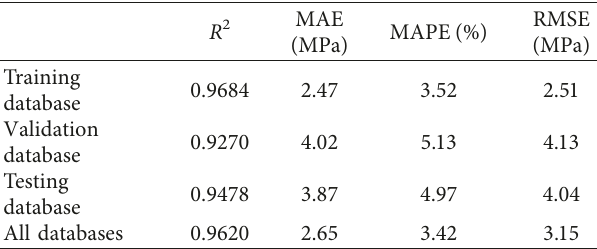
Figure 7: Fitting curve of outputs and targets. Table 5: Prediction performance of different patterns of this model.